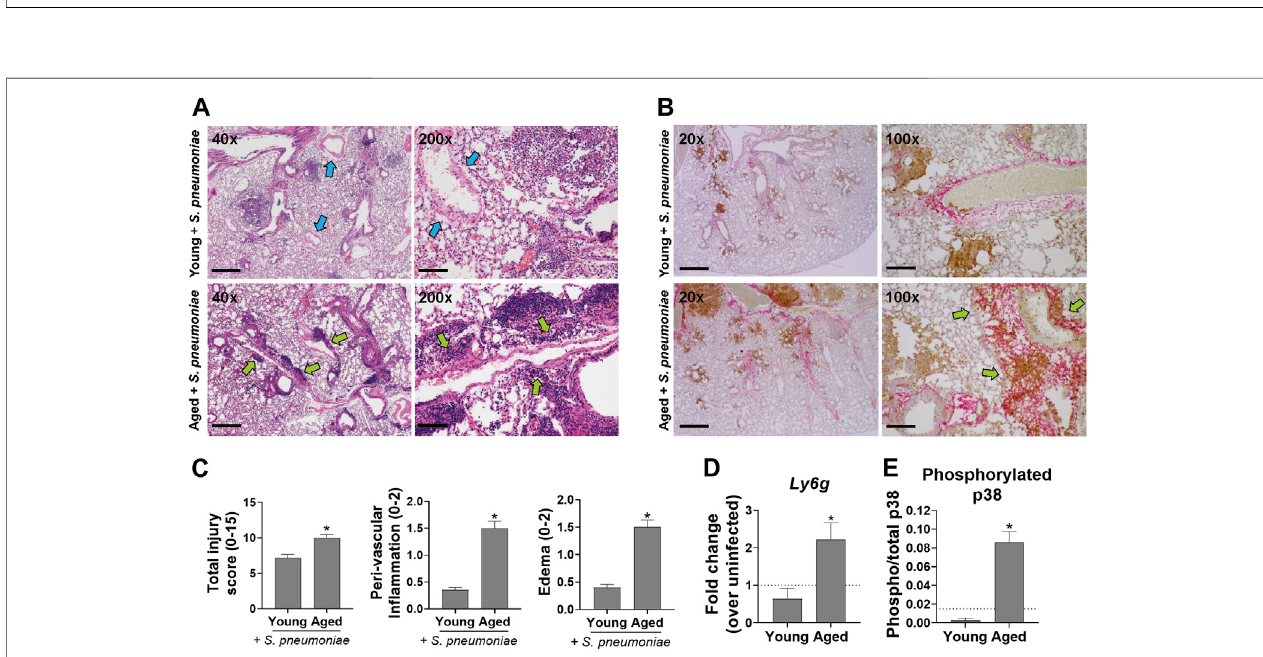
FIGURE 2 | Aged mice have increased lung in fl ammation following infection with S. pneumonia compared to young mice. (A) Representative images of H&E stained lungs from 4-6 mice per group at 40x and 200x magni fi cation are shown. Scale bars = 500 and 100 μ M microns respectively. Blue arrows point to vessels with minimal peri-vascular in fl ammation. Green arrows point to regions with peri-vascular in fl ammation. (B) IHC staining of lungs for neutrophils (Ly6G, brown) and S. pneumoniae (pink). Representative images from 4 – 6miceper groupat 20xand 100xmagni fi cation are shown.Scale bars =1000and 200 μ Mrespectively. Green arrowspointtoregionswithextensiveneutrophilin fi ltrationandperi-vascularin fl ammation. (C) Bargraphsshowinghistologicscoringofthelungs.Dataarepresentedas mean score for each group. * p < 0.05 compared to young-infected mice by t test. (D) qRT-PCR of Ly6g mRNA in whole lung tissue 24 h after infection with S. pneumoniae . n =8 – 10micepergroup.Dashedlineismeanlevelinyounguninfectedanimals(n=3).* p < 0.05comparedtoyoung-infectedmiceby t test. (E) Wholelung lysates were analyzed for phosphorylated and total p38 MAPK by ELISA. Data are mean phosphorylated/total p38 in infected animals. n = 4-6 mice per group. Dashed line is mean ratio of young uninfected animals (n = 2). * p < 0.05 compared to young-infected mice by t test.